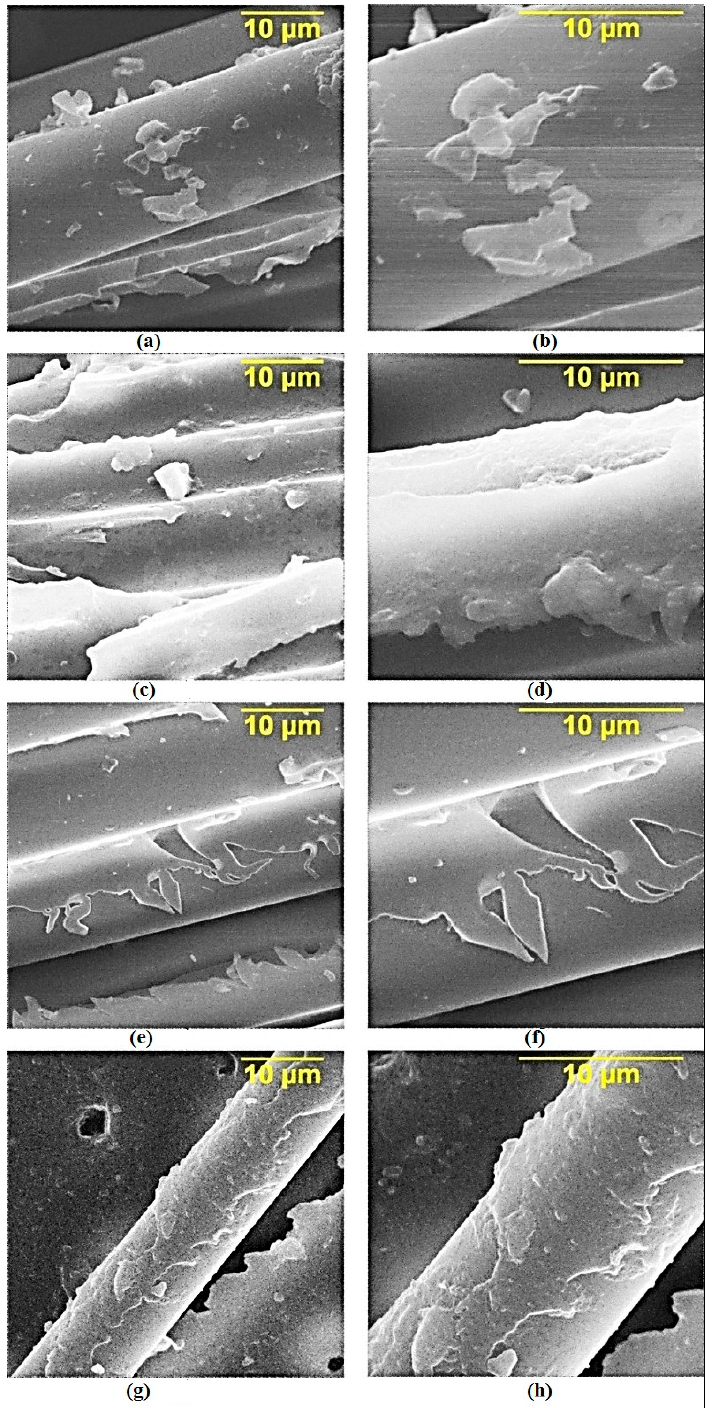
Figure 5. SEM data of unidirectional reinforced epoxy composites: ( a , b )—original composite; ( c , d )—composite with 0.1 part by mass of GO; ( e , f )—composite with 0.1 part by mass of GO functionalized with APTES; ( g , h )—composite with 0.1 part by mass of GO functionalized with aminoacetic